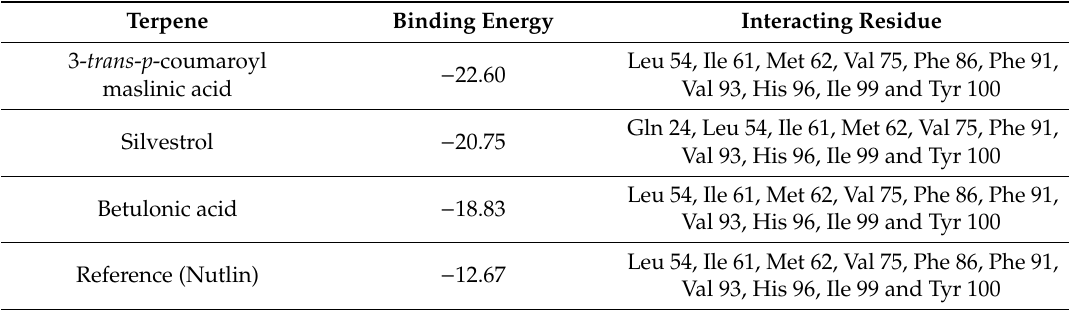
Table 2. Binding energy score and details of interacting residues of finally selected terpenes hits against